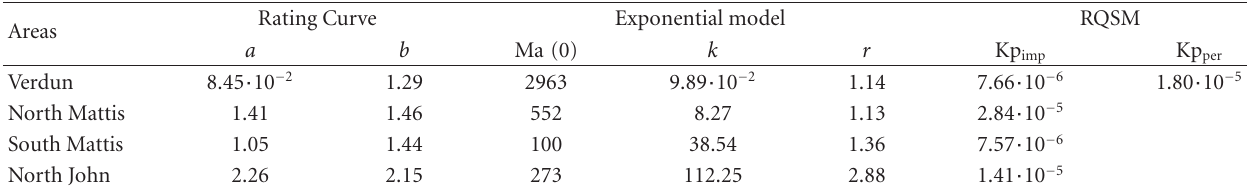
Table 3: Parameter values after calibration of the RQSM, Rating Curve, and Exponential models. R ating Curve Areas